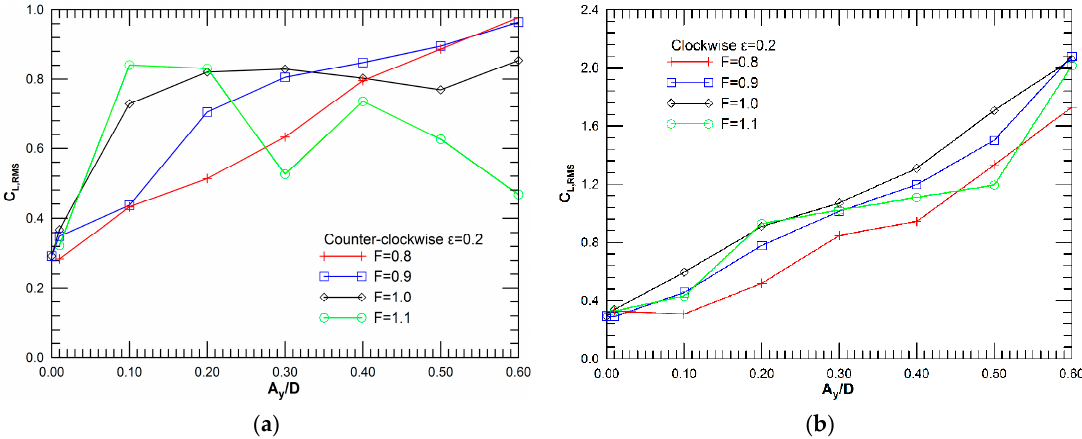
Figure 4. Variation of the RMS of the lift coefficient, C L,RMS , for ε = 0.2 versus the non-dimensional amplitude A y /D, for frequency ratio F = 0.8, 0.9, 1.0, 1.1: ( a ) counter-clockwise cylinder oscillation, ( b ) clockwise cylinder oscillation.